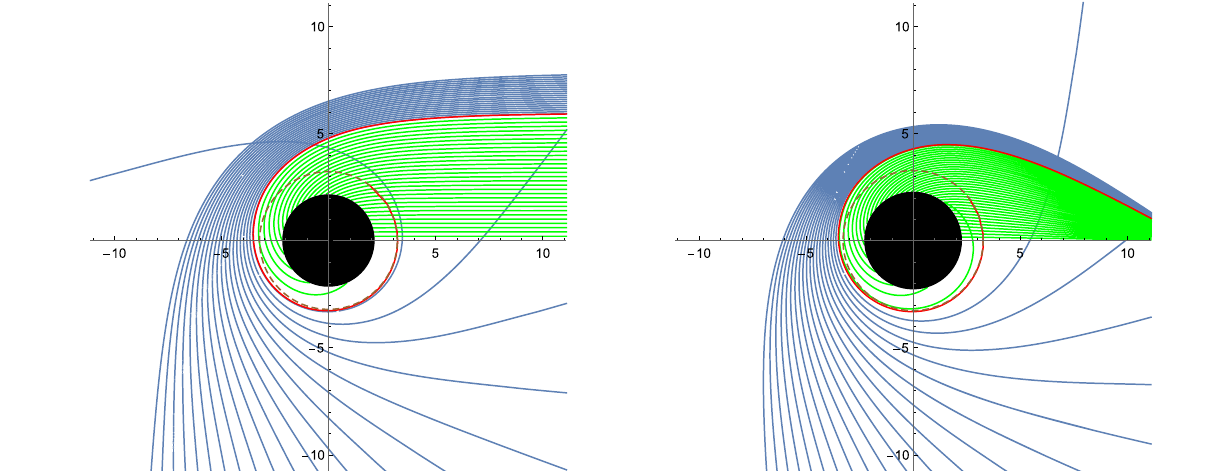
black hole from the right side. The green, red and blue lines correspond to b < b ph , b = b ph and b > b ph